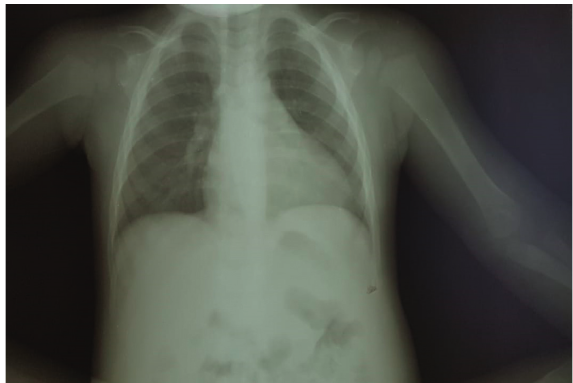
Figure 1: Posteroanterior chest radiograph depicting cardiothoracic ratio > 50% by cardiac silhouette.